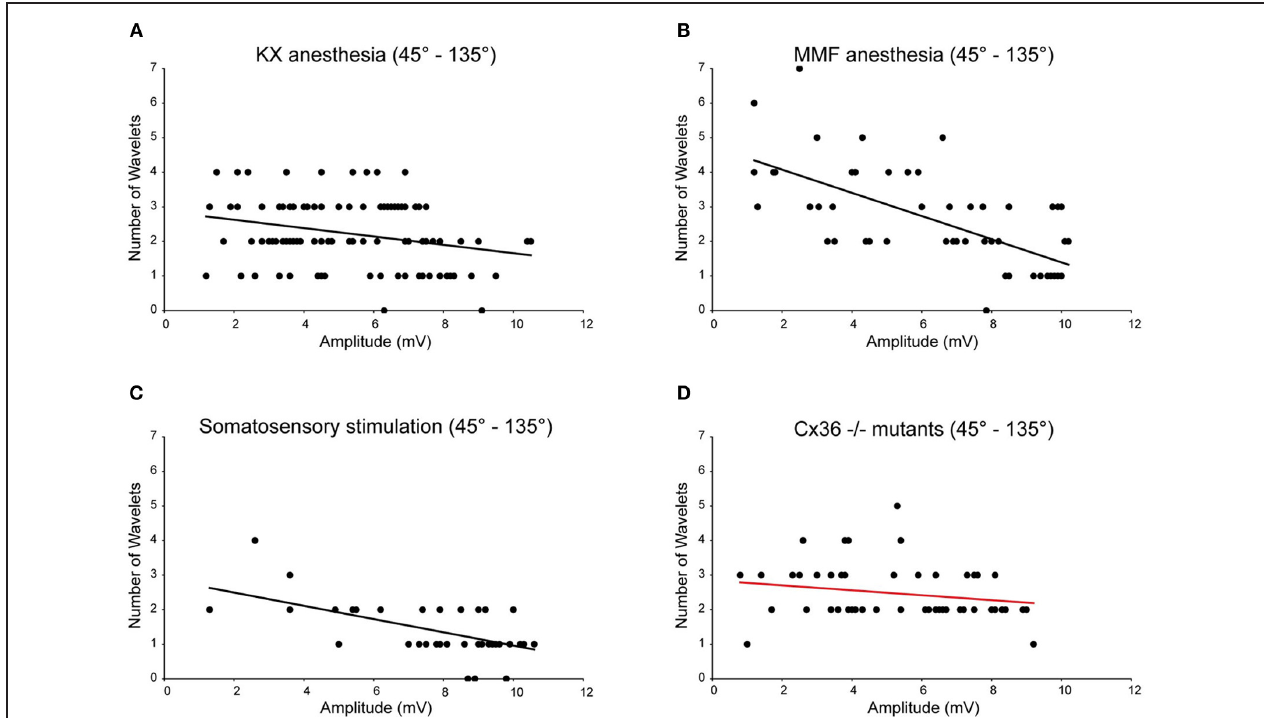
significantly correlated under KX conditions [ A ; r KX = − 0 . 27, n = 110 (71%), p < 0 . 01 ( t -test)] and under MMF conditions [ B ; r MMF = − 0 . 67, n = 56 (77%), p < 0 . 01 ( t -test)]. Amplitude of the oscillation and number of olivary spike wavelets are significantly correlated when measured on somatosensory evoked spikes [ C ; r SSS = − 0 . 55, n = 44 (56%), p < 0 . 01 ( t -test)] and are not significantly correlated when measured in Cx36 − / − mutant mice [ D ; r CX36 = − 0 . 21, n = 53 (64%), p > 0 . 05 ( t